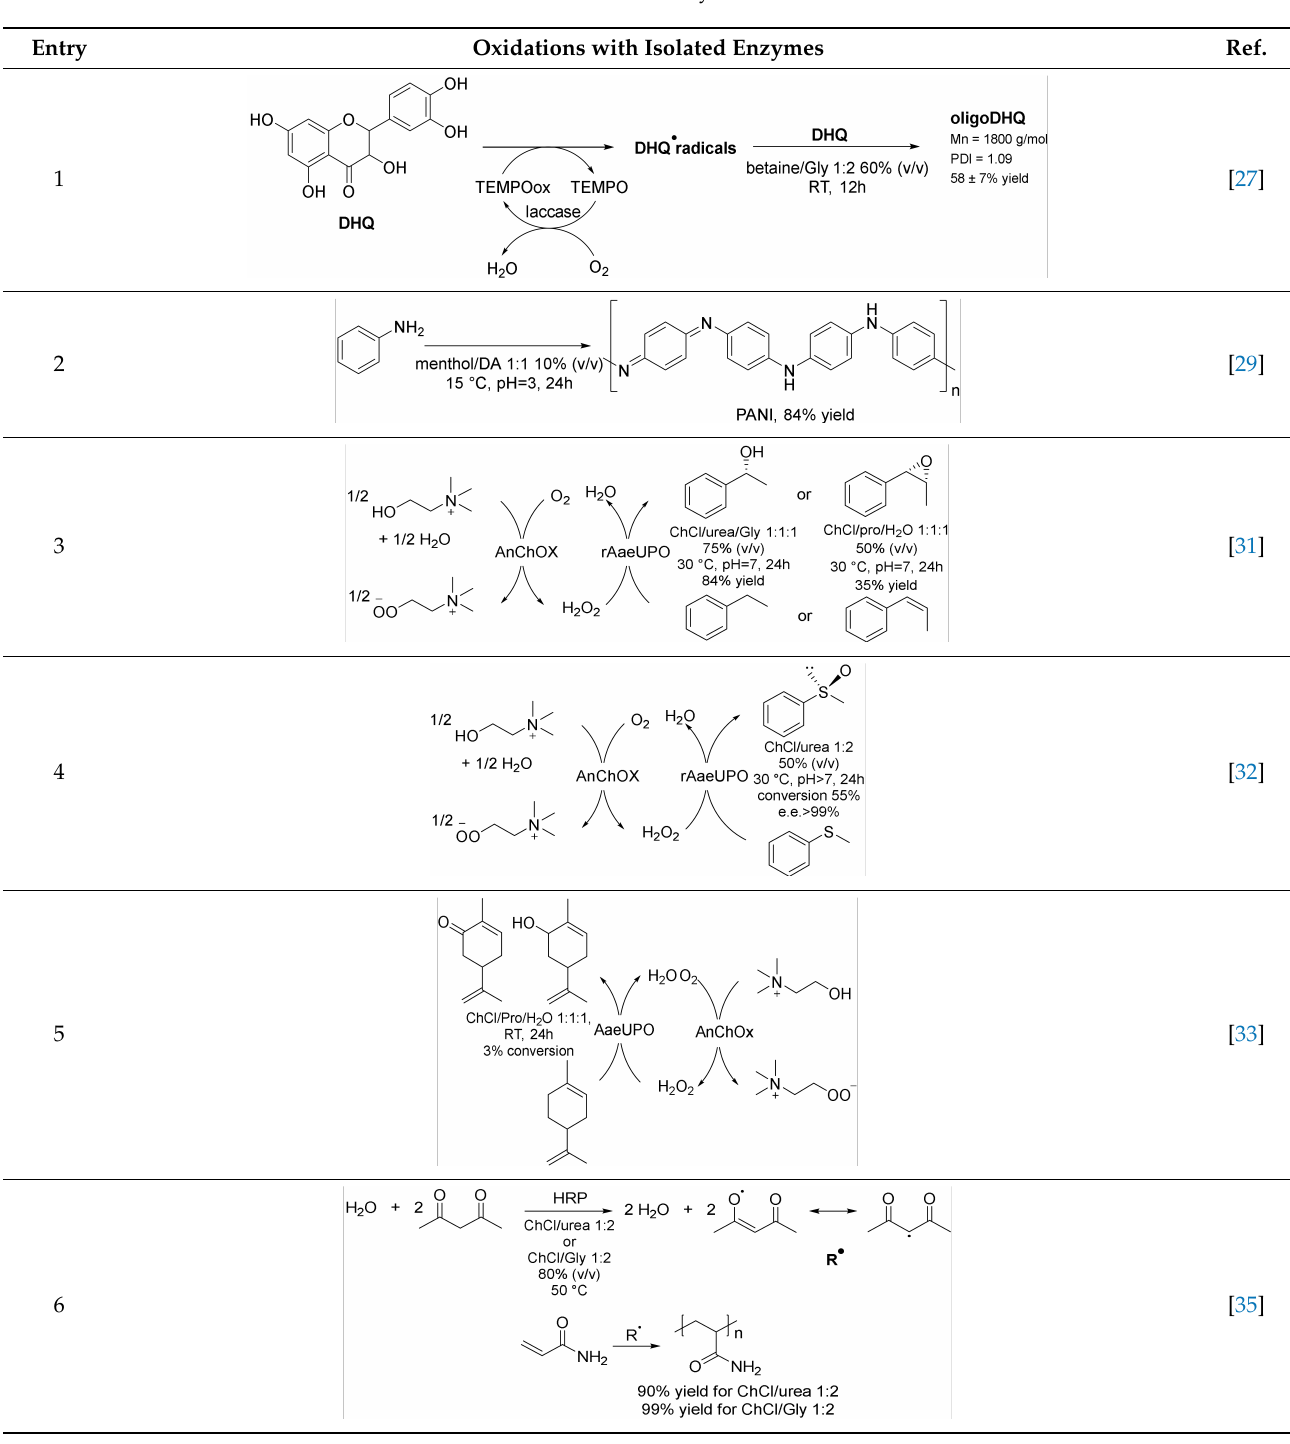
Table 3. Oxidations with isolated